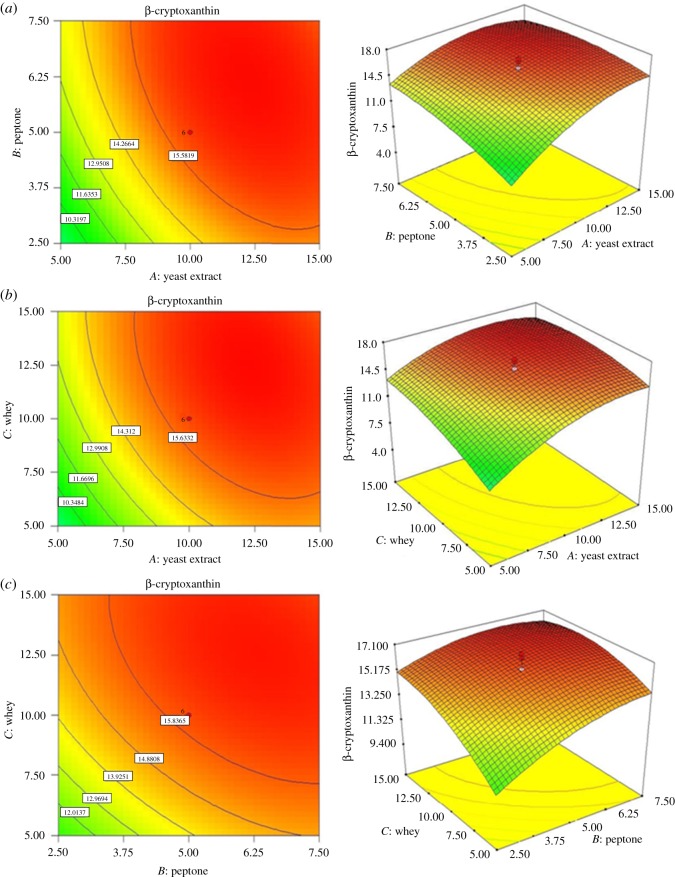
Contour plots and their corresponding 3D diagrams for β-CRX yield.